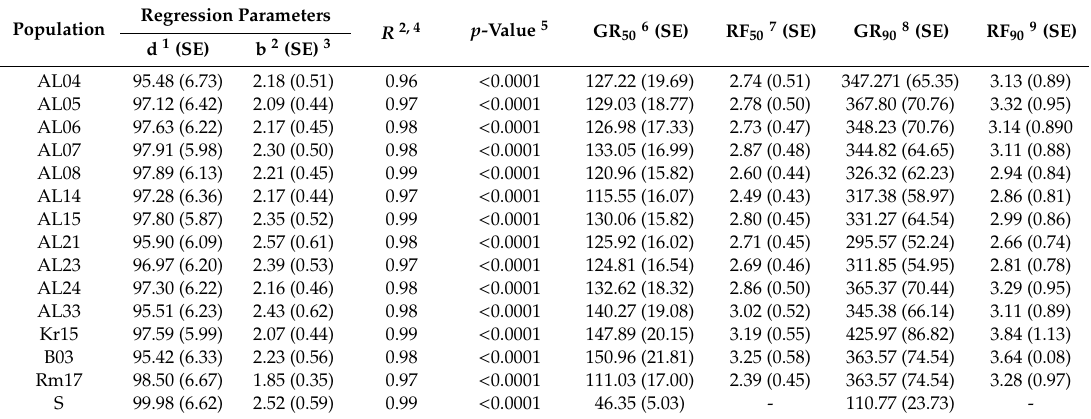
Table 5. Estimated non-linear regression parameters for the P. brachystachys populations in. response to cycloxydim based on dry weight.